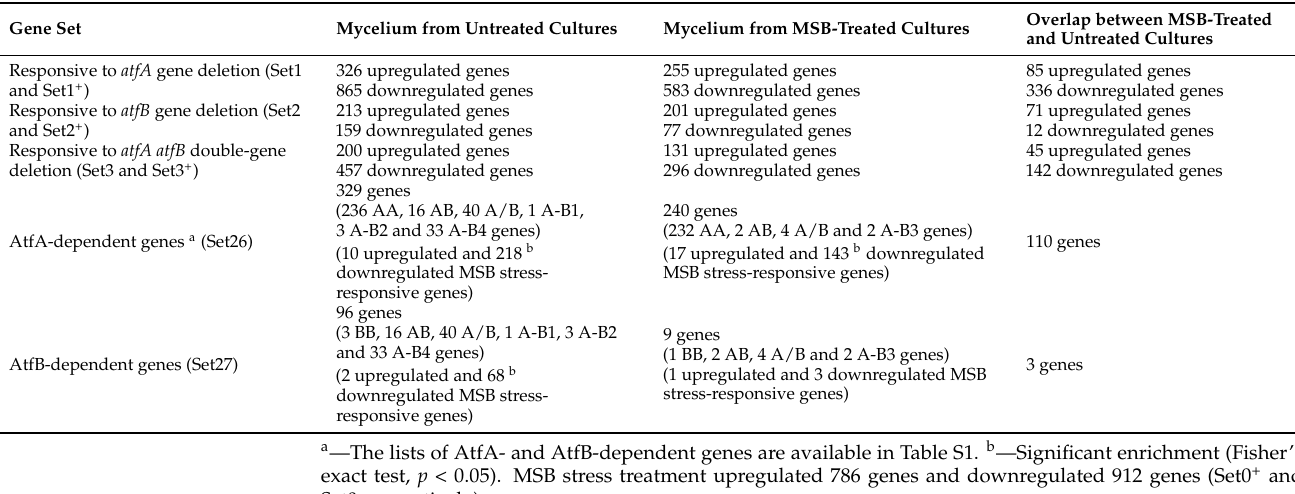
Table 1. Characteristics of the main gene sets identified with mycelial samples.